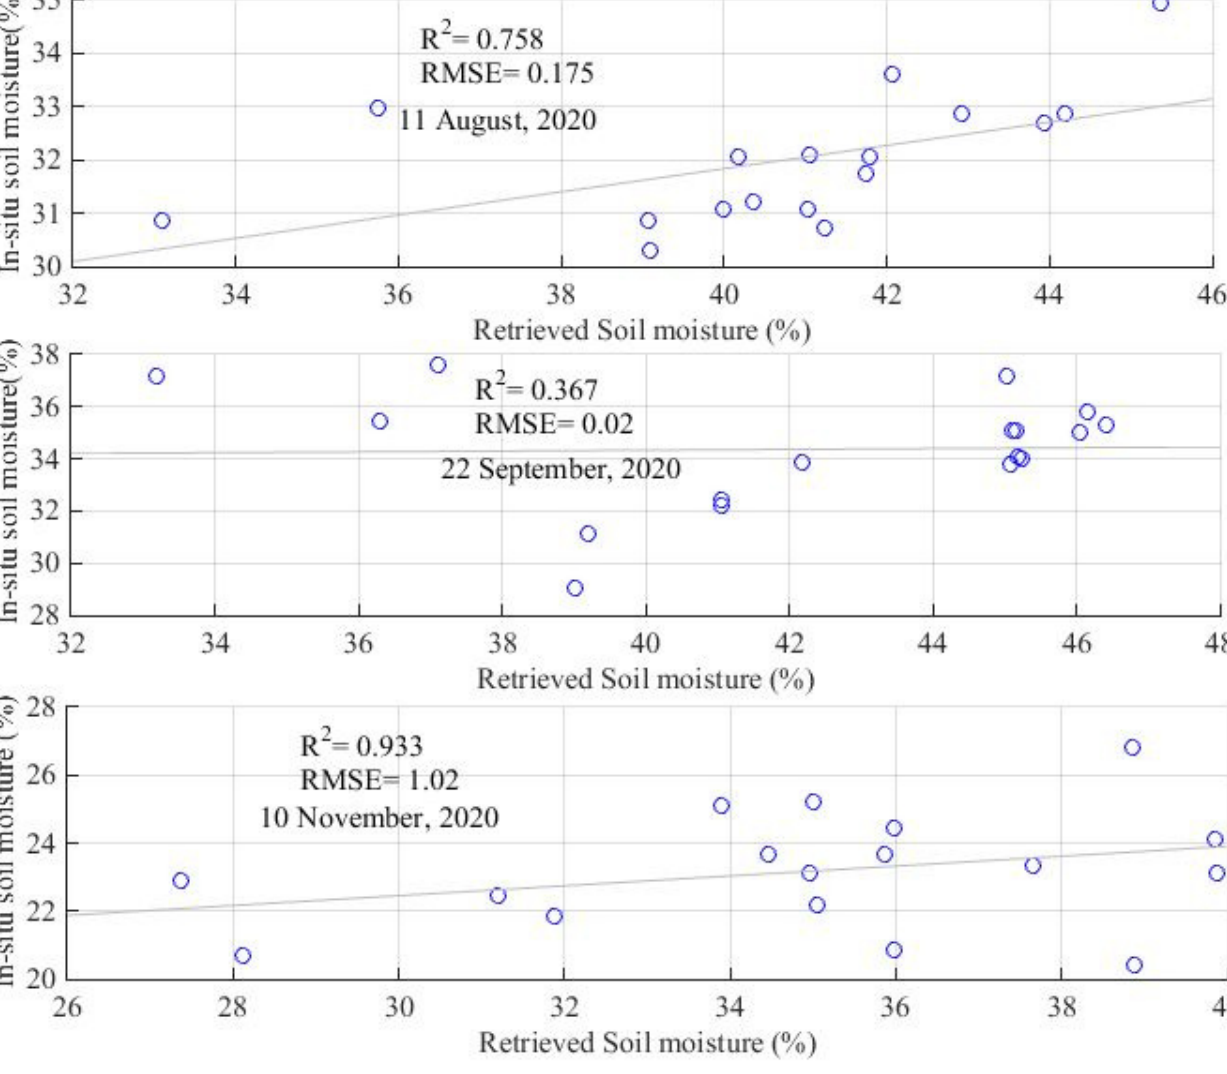
Figure 10. Correlation of in-situ soil moisture and WCM-based soil moisture estimate during the cropping season in Sholit (untreated) watershed.